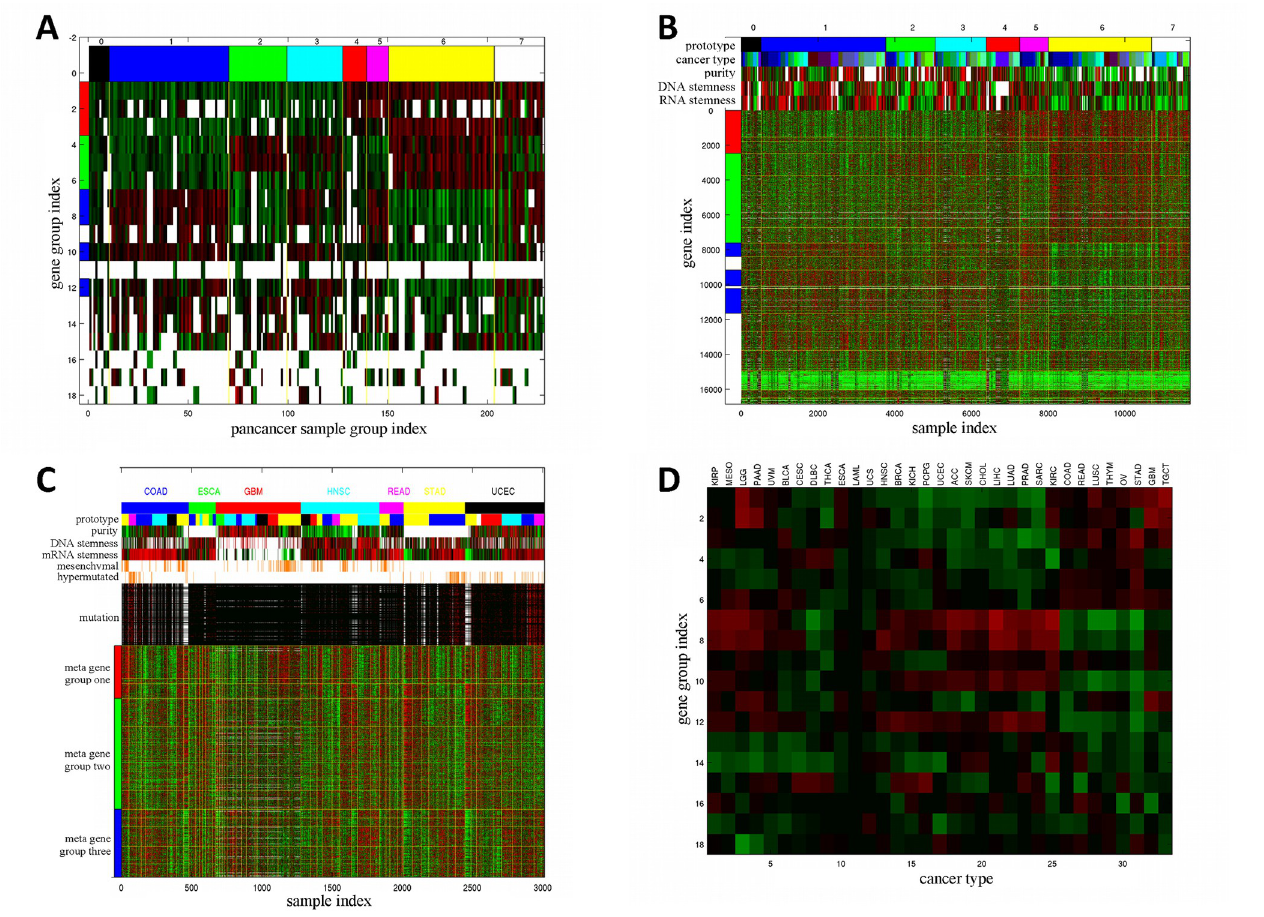
Fig 4. Summary of Pan-cancer Sample Groups and alignments with clinical features. A : Combinatorial expression patterns of 18 Gene Groups (rows) in 228 Sample Groups (columns). The three Meta Gene Groups are marked on the left: Meta Gene Group 1 (immune and inflammatory responses, red), Meta Gene Group 2 (embryonic development and neurogenesis, green), Meta Gene Group 3 (cell cycle process and DNA repair, blue). Sample Groups are sorted by the combinatorial expression patterns of Meta Gene Groups. The 8 Pan-cancer Sample Groups (0–7) are marked on the top and separated by yellow vertical lines. A white patch indicates that a Gene Group is not enriched in any Super Module in the cancer types of a Sample Group. B : Expressions of 16860 genes in 11701 samples. Genes are sorted by Gene Groups, and Meta Gene Groups are marked on the left. Samples are sorted by Sample Groups and Pan-cancer Sample Groups. Gene Groups and Pan-cancer Sample Groups are separated by yellow boundaries. The Pan-cancer Sample Groups (prototypes), cancer types, sample purity, DNA and RNA stemness of samples are displayed on the top. C : mRNA expressions of three Meta Gene Groups overlaid with several pan-cancer features in seven cancer types. Samples within each cancer type are sorted by Sample Groups. The following sample features are also displayed: cancer types, prototypes (Pan-cancer Sample Groups), sample purity, DNA and RNA stemness, mesenchymal states, hyper-mutated states, and mutations of selected genes. Prototype color codes follow the top row in panel B . D : Direction and strength of mRNA expression-survival time associations ( p diff scores of Cox regression coefficient distributions) of all Gene Groups in all cancer types. Positive and negative deviations (indicating positive and negative Cox regression coefficients) have red and green colors